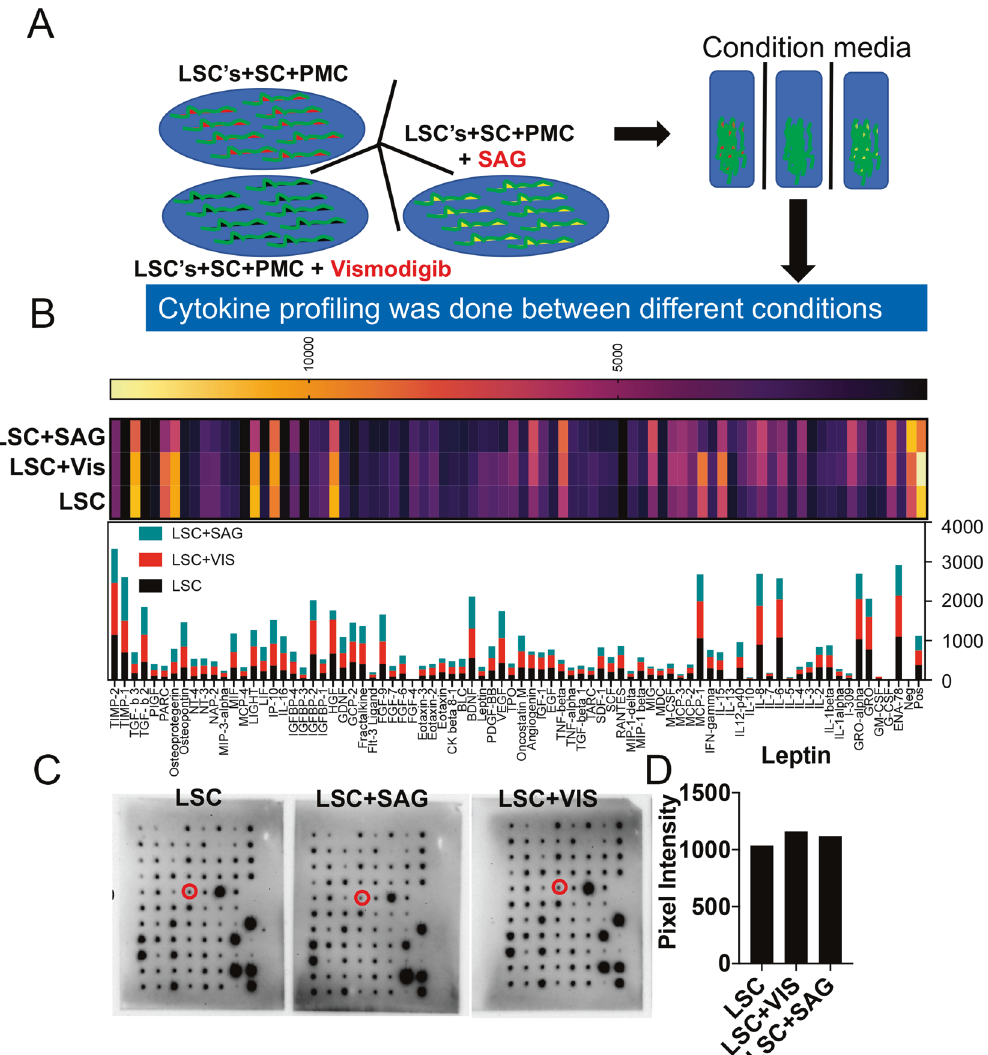
Fig. 4 Leptin is upstream of DHH signaling in TME. Leptin is upstream of DHH signaling in TME. A Schematics of experiment in which LSCs were treated with DHH agonist or antagonist in the presence of the TME, followed by extraction of condition media to perform cytokine antibody array. B Analysis results of the cytokine array between three different conditions (control, DHH agonist treatment, and DHH antagonist treatment). C Blots showing cytokine array with three experimental conditions. D Quanti fi cation of Leptin expression levels between the three